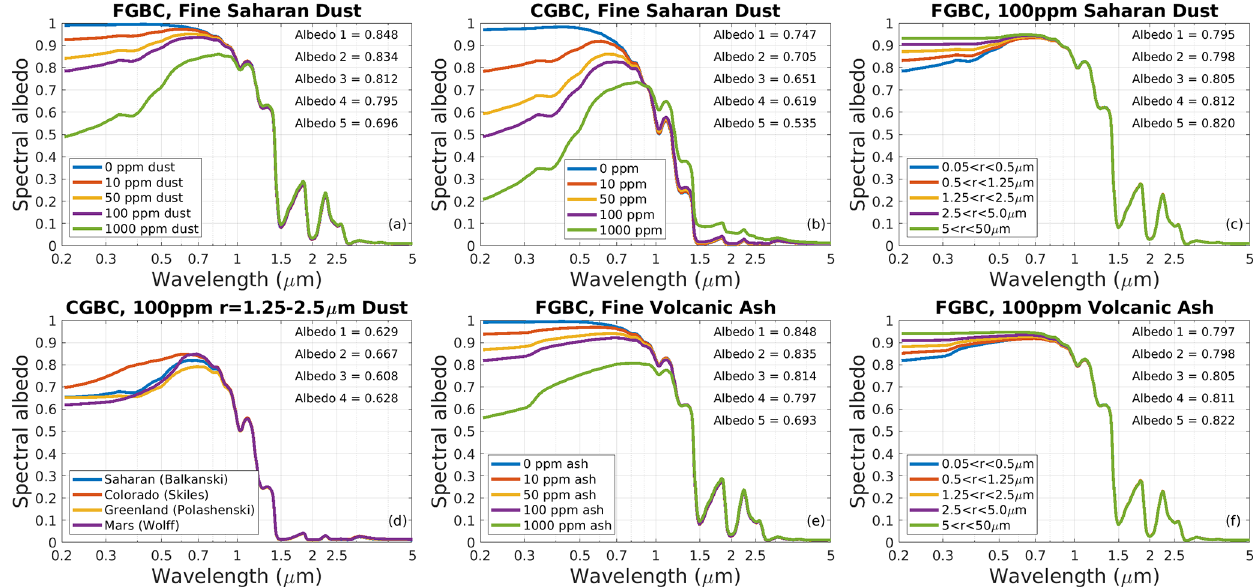
Figure 7. Albedo variations caused by mineral dust ( a–d ) and volcanic ash ( e, f ). Spectral albedo perturbations are shown for fine- grain (a) and coarse-grain (b) base cases with different mixing ratios of the smallest size bin of Saharan dust, for different particle sizes of Saharan dust with a mixing ratio of 100ppm in the fine-grain base case (FGBC) (c) , and for different types of dust in the coarse-grain base case (CGBC), with an intermediate particle size (1 . 25 < r < 2 . 5µm) and mixing ratio of 100ppm (d) . Albedo variations for volcanic ash are shown for different mixing ratios (e) and particle sizes (f) in the fine-grain base case. The order of broadband albedos shown in each panel corresponds with the legend